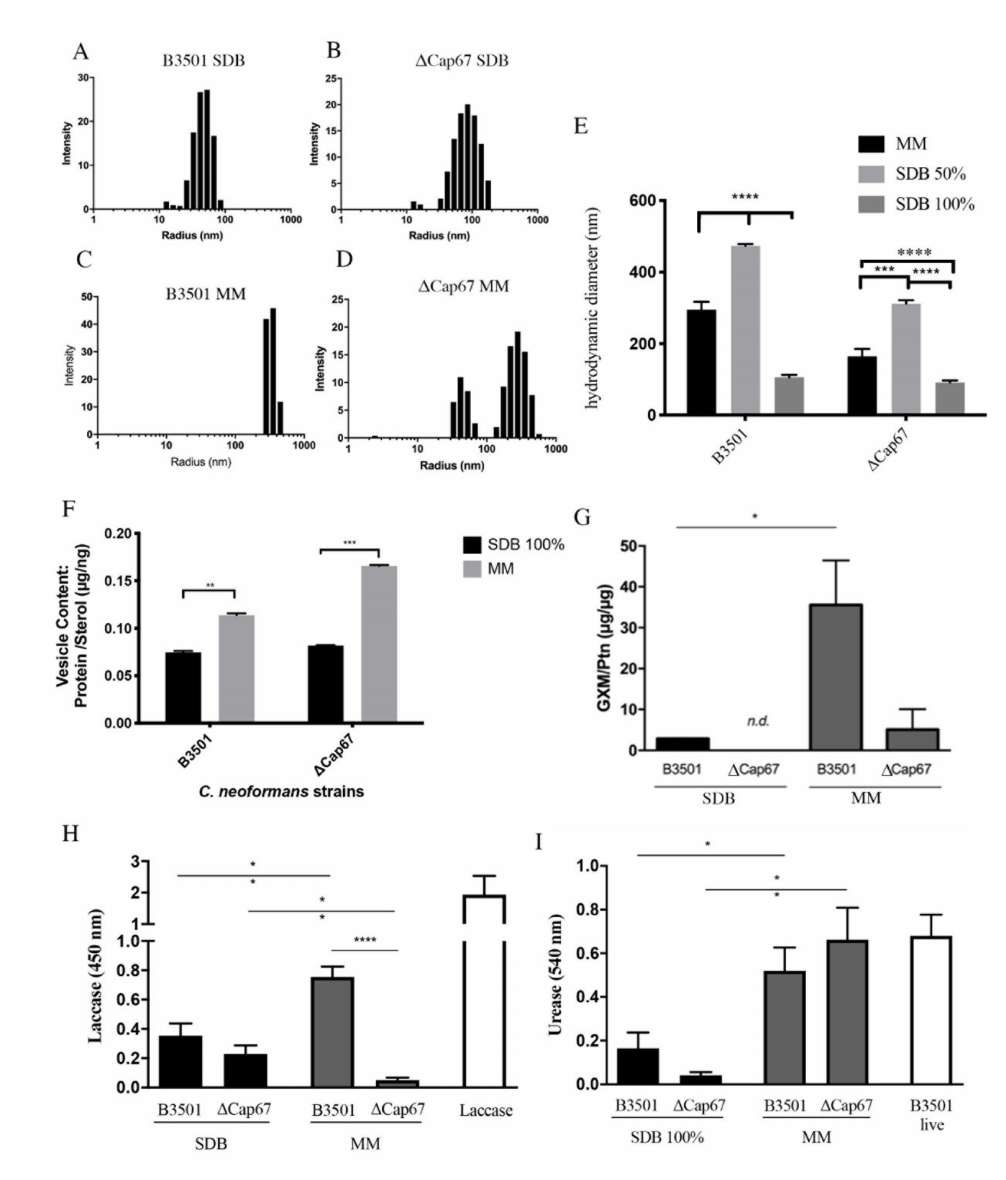
Figure 1. Extracellular vesicles (EVs) produced in a nutrient-poor medium have a higher hydrodynamic diameter and di ff erent virulence molecules activities than those produced in a nutrient-rich medium. EVs were isolated from C. neoformans strains B3501 ( A , C ) and ∆ Cap67 ( B , D ) grown in a poor medium (minimal medium (MM)—( C , D ) or Sabouraud dextrose broth (SDB) 50%—( E ) or in a rich medium (SDB 100%)( A , B , E )andweresubmittedtodynamiclightscattering(DLS)analysis. Subfigures( A – D )showthe distribution of EVs in suspension according to the average radius in nanometers (nm), and ( E ) compares hydrodynamic diameter averages depending on the culture medium utilized. Protein / sterol ratio of EVs was quantified using colorimetric assays Amplex Red Cholesterol assay kit for sterol quantification and Micro BCA Protein assay kit for protein quantification ( F ); glucuronoxylomannan (GXM) content was measured by enzyme-linked immunosorbent assay (ELISA) ( G ). Laccase ( H ) and urease ( I ) enzymatic activities were measured spectrophotometrically. Laccase and B3501 live are positive controls for the enzymatic activity. For all plots, * indicates p < 0.05, ** indicates p < 0.01, *** indicates p < 0.001, **** indicates p < 0.0001 according to one-way analysis of variance (ANOVA) ( E – F ) and Student’s t -test (fig. G – I ). n.d. means non detected. The data are expressed as the mean ± standard error of the mean (SEM) of triplicates and represent at least two ( G – I ) or three ( A – F ) independent